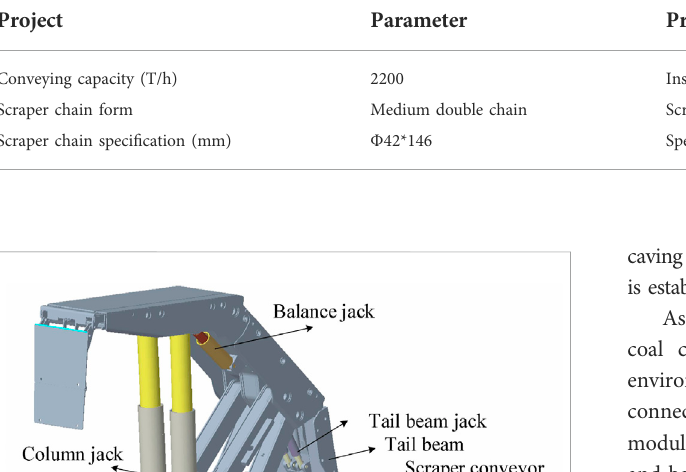
TABLE 2 Technical parameters of SGZ1000/1400 scraper conveyor.